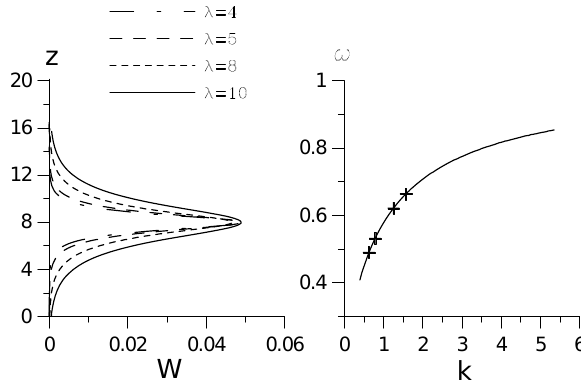
Fig. 2a. Distribution of the vertical velocity W(z) for wavelengths Fig.2a. Distribution of the vertical velocity W ( z ) for wavelengths 4,5,8 and 10 (left) and the 4, 5, 8 and 10 (left) and the dispersion relation ω(k) (right) for dispersion relation )( k ω (right) for the first IW mode. The wavenumbers corresponding to the the first IW mode. The wavenumbers corresponding to the selected wavelengths λ = 4 , 5, 8 and 10 are shown by selected wavelengths λ = 4, 5, 8 and 10 are shown by symbols.